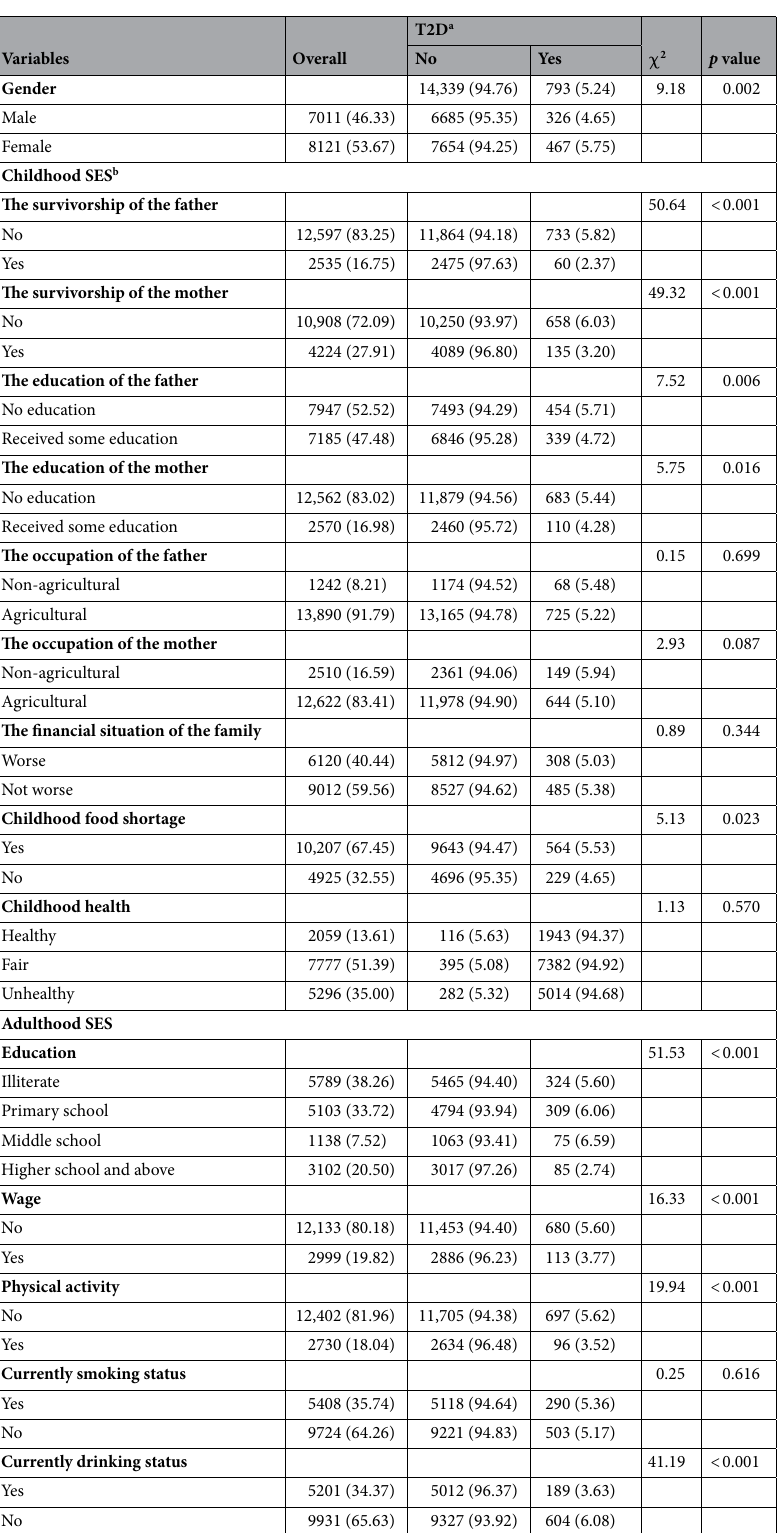
Table 1. Descriptive statistics of the participants ( N = 15,132). a Type 2 diabetes; b Socioeconomic